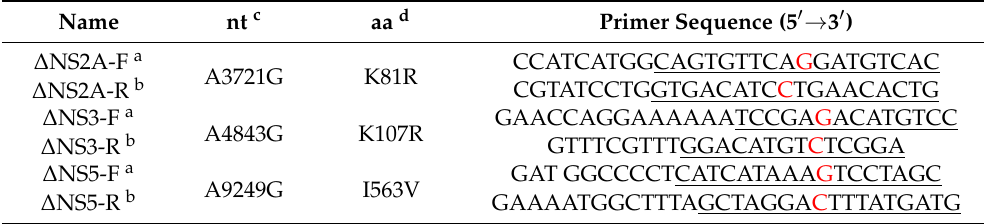
Table 1. Mutagenic primers used for construction of NS2A, NS3, and NS5 mutant